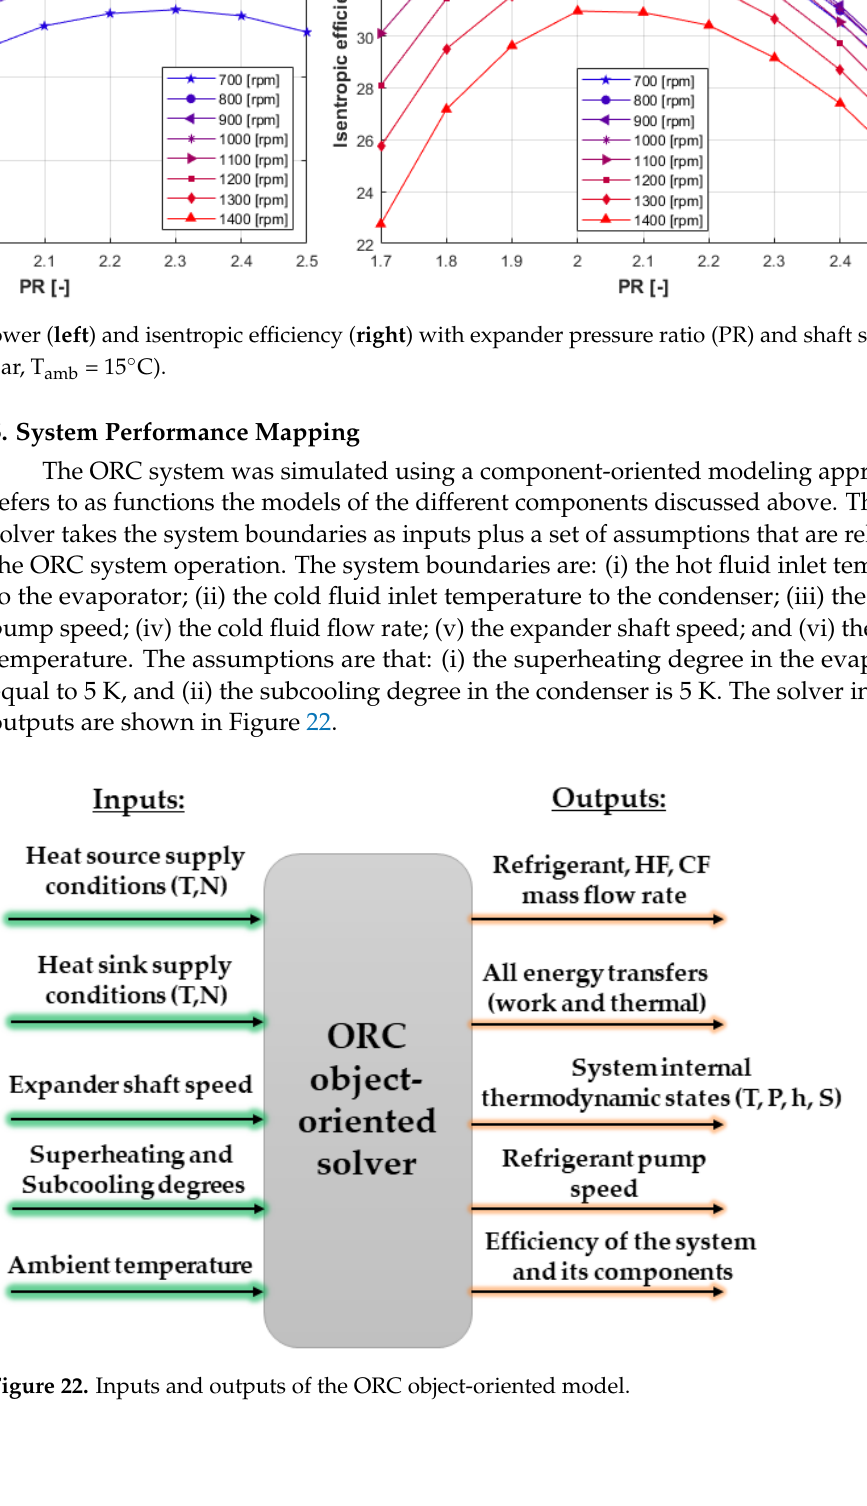
22 of 32 Figure 20. Results of the evaporator hydrothermal model vs. experimental data: refrigerant discharge temperature ( top- left ), diathermic oil discharge temperature ( top-right ), thermal load in the refrigerant side ( bottom-left ), and temperature profile for one of the experimental points ( bottom-right ). The lower accuracy of the evaporator model compared to the condenser one is due to the higher ambient heat losses from the evaporator compared to the condenser because of the significantly higher temperature of the evaporator. The heat losses also occur in the hot fluid pipe since the temperature sensors had a distance from the evaporator inlet and outlet ports. Another reason for the lower accuracy goes back to the higher fluctuations of the evaporator inlet and outlet pressures due to the direct impact of the plunger pump pulses and variations of the heat source temperature as discussed in the hydraulic mod- eling subsection. Nonetheless, the accuracy of the model for both the evaporator and con- denser of the ORC unit can be considered satisfactory for rating their performances properly. 4.4. Scroll Expander The scroll expander is an open-drive, lubricated machine converted from a refriger- ant compressor. The test bench is not equipped with a dedicated oil separator circuit; hence, the lubricant oil is mixed with the refrigerant and circulates in the system. It is modeled using a semi-empirical model developed by some authors of this work, which